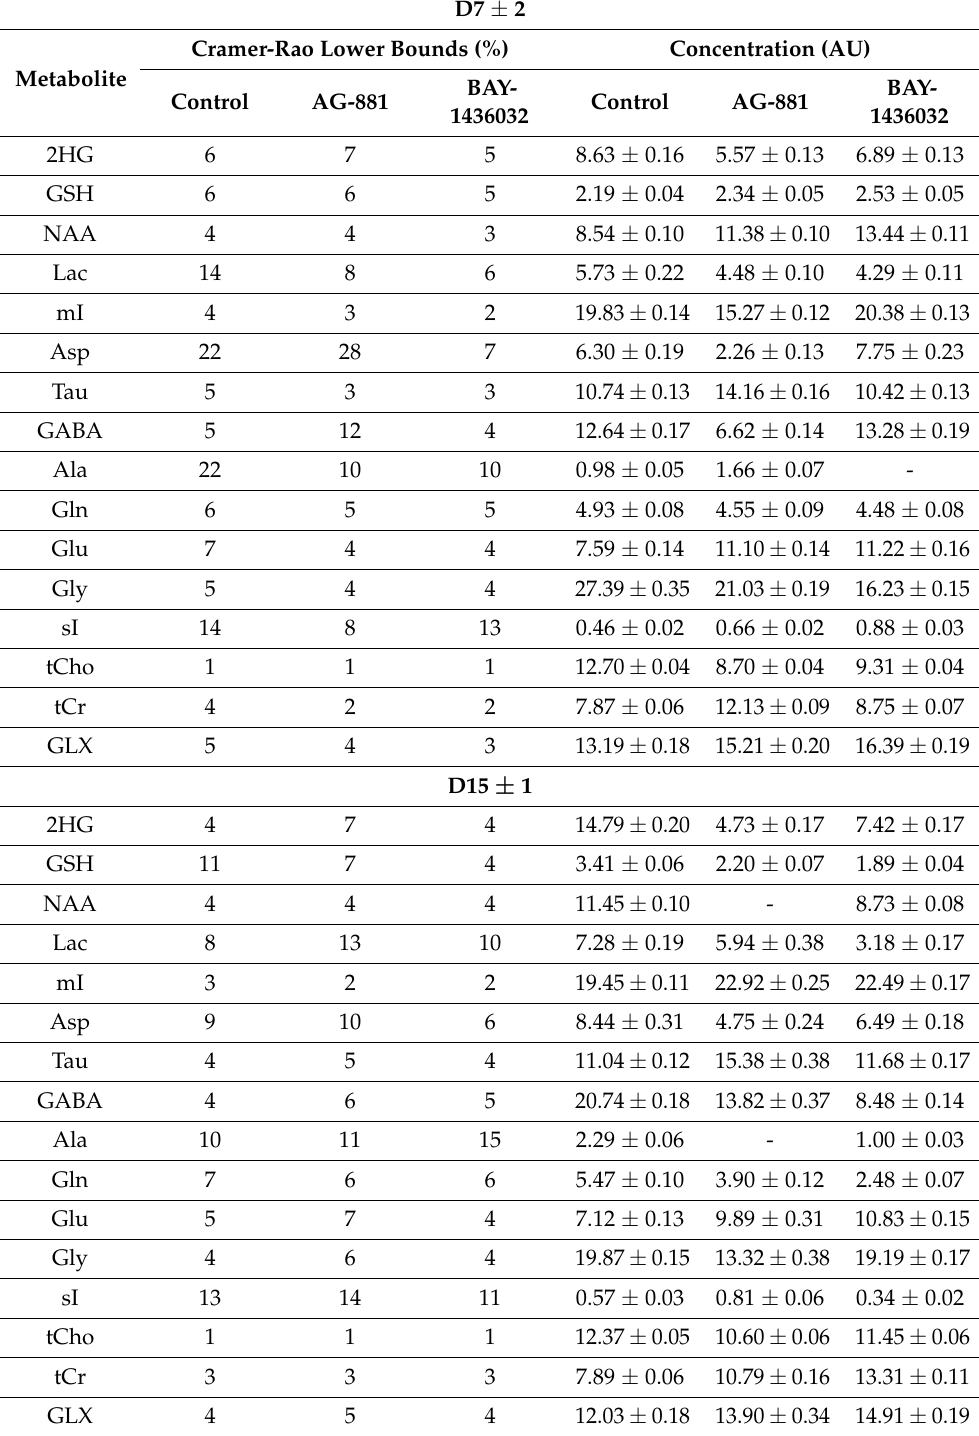
Table 2. Metabolite levels significantly different between control and treated BT257 tumors at early (D7 ± 2) and late (D15 ± 1) time